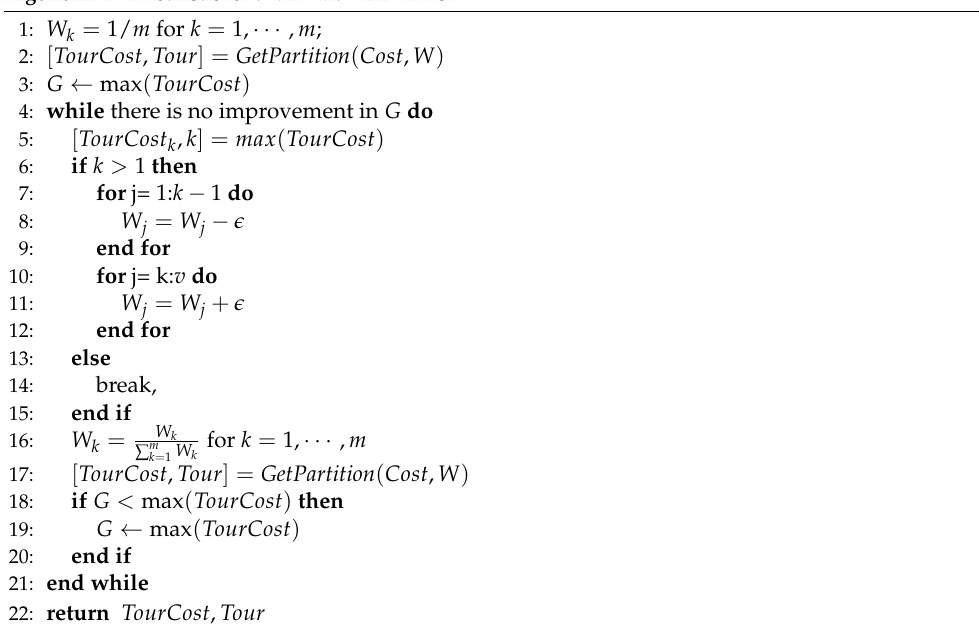
Algorithm 1 A Heuristic for a Min–Max